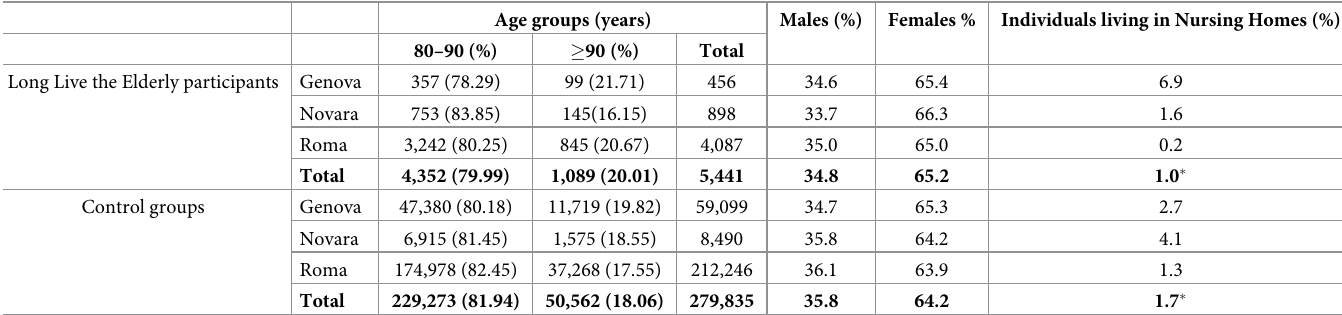
Table 1. Population by age groups and sex.